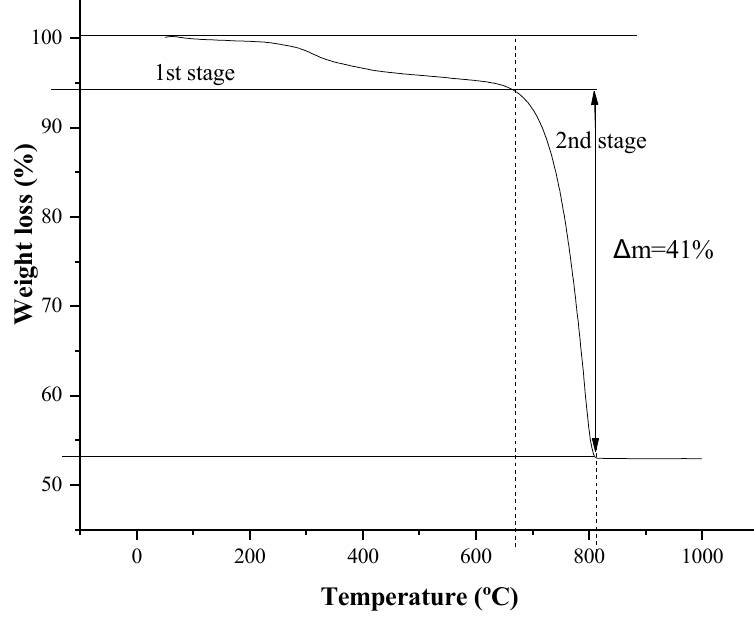
Figure 2. Weight loss of calcium carbonate as a function of temperature.